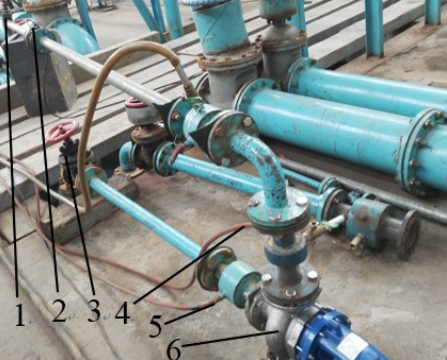
Figure 3. Experimental device: (1) valve in the outlet, (2) flowmeter, (3) valve in the inlet, (4) pressure transducer in the outlet, (5) pressure transducer in the inlet, (6) pump.